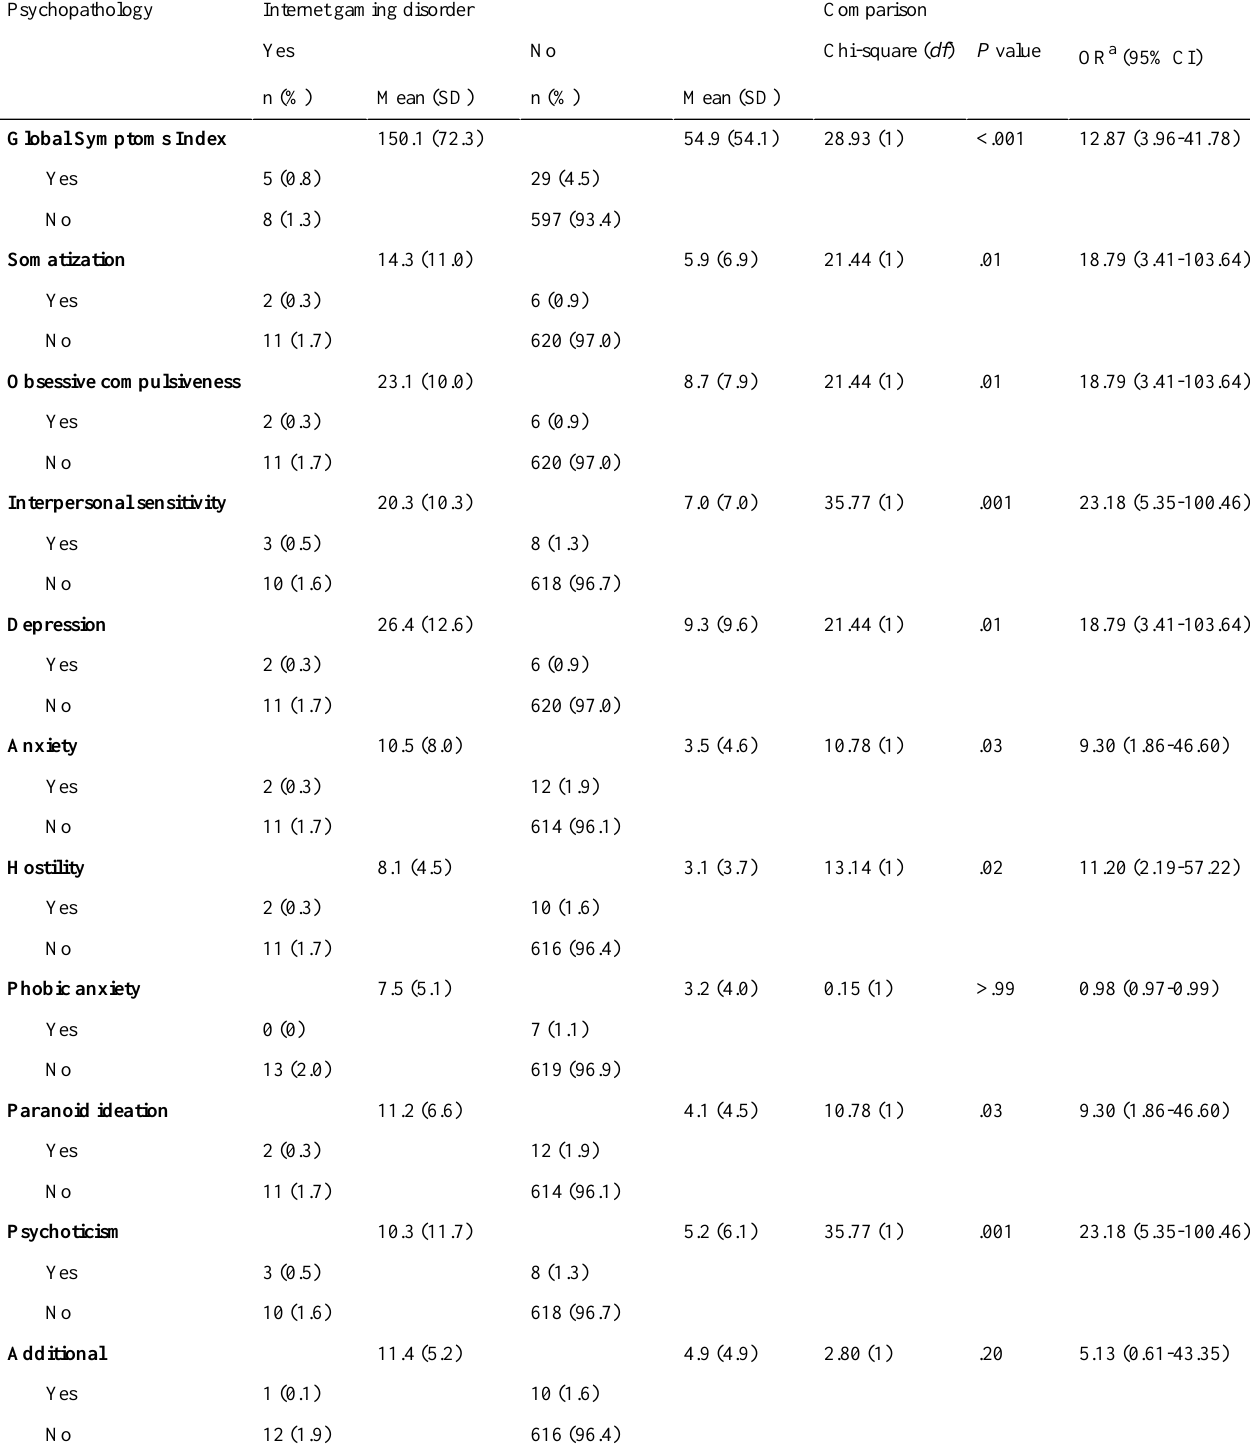
Table 4. Symptoms Checklist 90 and internet gaming disorder. ComparisonInternet gaming